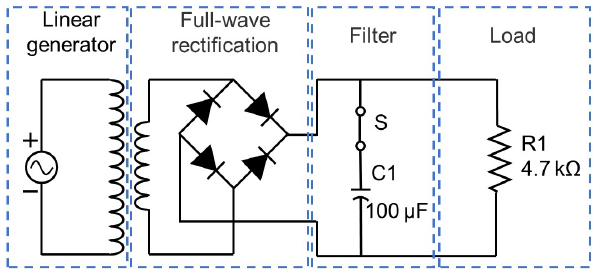
Figure 18. Rectifier filter circuit diagram.